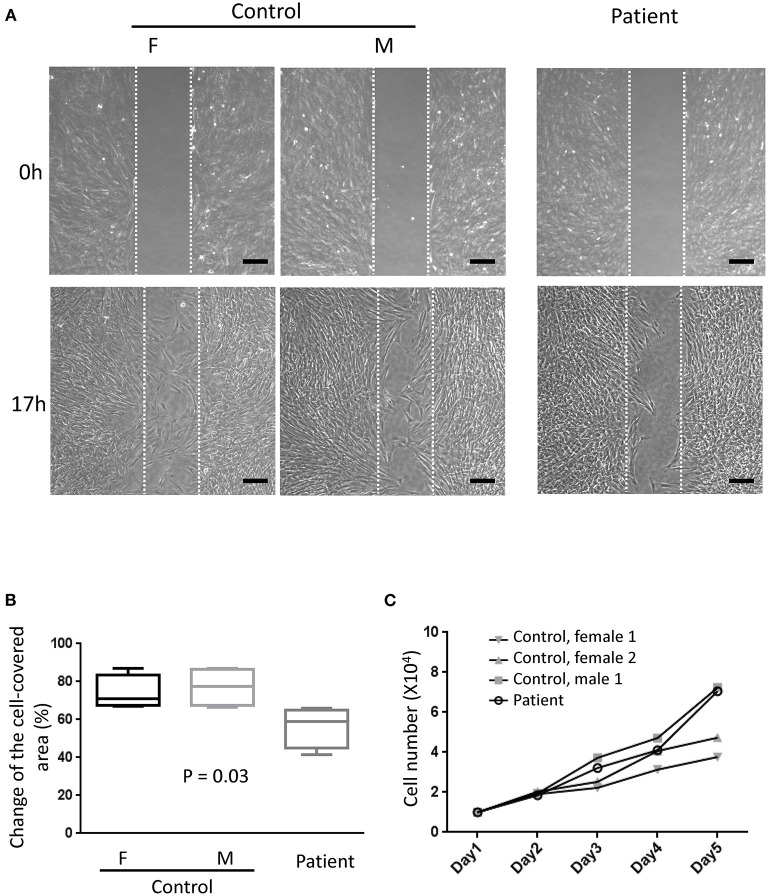
Migration assay. (A) Representative photographs from six independent experiments showing cell density at the beginning of removing culture insert and 17 h later. The area between the two parallel white dot lines indicated where the culture insert was (F, female; M, male; scale bar, 200 μm). (B) Comparisons of the change of the cell-covered area over time between patients and control subjects. One-way ANOVA, p = 0.03. (C) The proliferation assays showed no difference between primary fibroblasts from the patient and control subjects. Two-way ANOVA, six independent experiments.